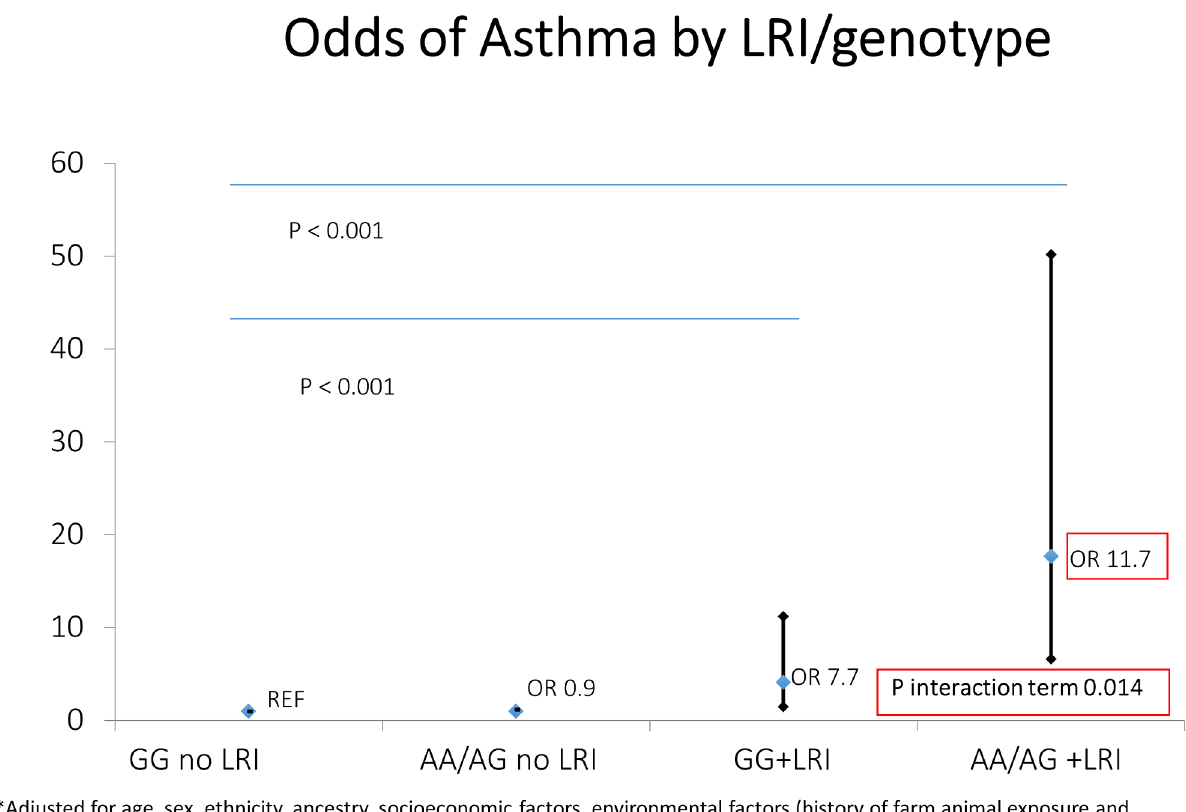
Fig 2. Joint association of early life lower respiratory tract infection and PAI-1 risk genotype ( rs2227631 ) with Asthma. LRI indicates subjects who were diagnosed with a lower respiratory tract infection requiring medical attention before age 2 years old. Adjusted for age, sex, ethnicity, ancestry, socioeconomic factors, environmental factors (history of farm animal exposure and received antibiotics during first year), family history of asthma and recruitment